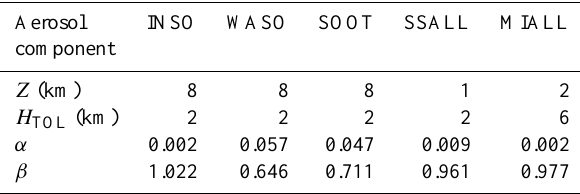
Table B1. Parameters defining the vertical structure ( Z and H TOL ) of each GADS-based aerosol component in SIRAMix are given. Also, coefficients for the conversion of AOD at 550nm to the short- wave range ( α and β ) are given for each aerosol component to com- plete Eq. (B8). Aerosol INSO